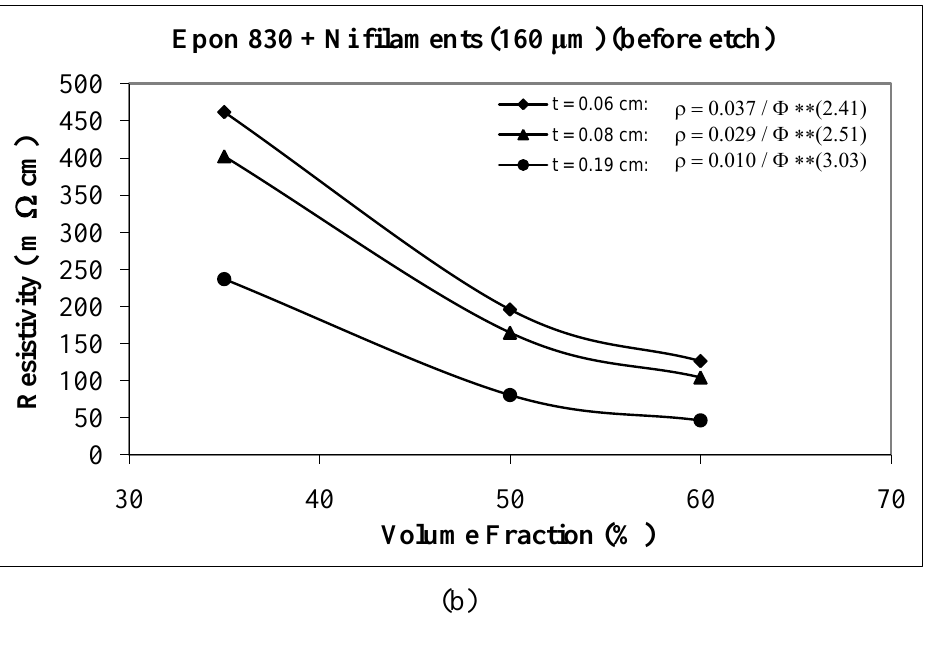
Figure 19. Volume fraction-thickness dependent resistivity of Epon 815C ( a ), and 830 ( b ) films filled with etched nickel filaments (160 